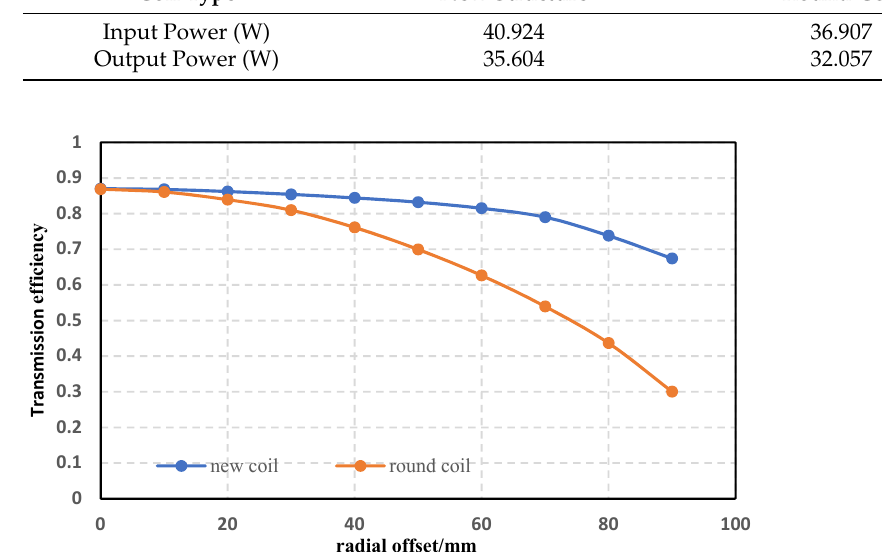
Figure 14. The magnitude of the change in the transmitted power when the new coil and the circular coil are offset.